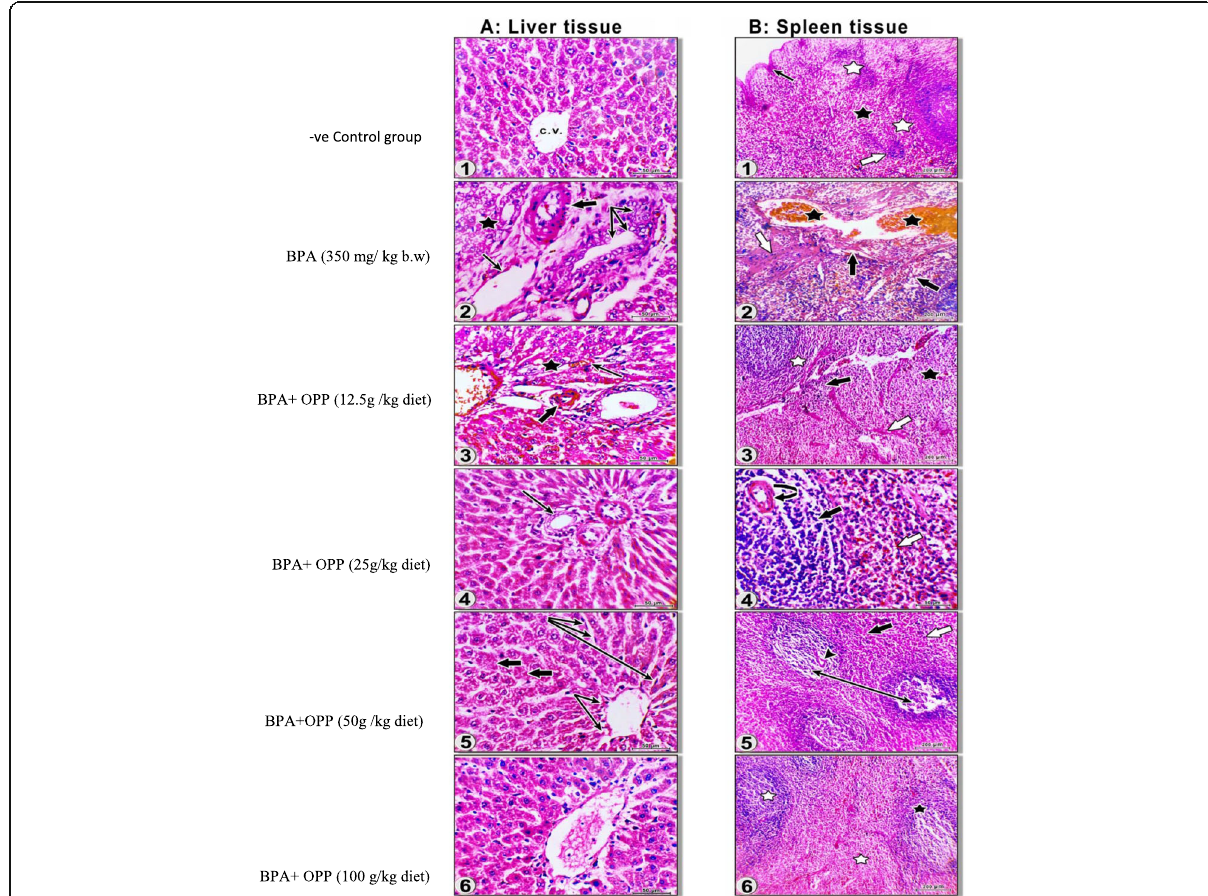
Fig. 1 a Photomicrographs of hepatic micro-anatomical structures. (1) Control group illustrating normal hepatocytes and central vein (cv), (H&E × 400). (2) Rats administered BPA (350 mg/kg b.w/twice weekly) showing necrotic area (star), bile duct hyperplasia (3 arrows), hypertrophy portal artery (thick arrow) dilated vein (thin arrow), and (H&E × 400). (3) Rats administered BPA and orange peel powder (12.5 g/kg diet), illustrating the hemorrhage (thin arrow), fibroid with lymphocytes infiltration (thick arrow), and areas markedly improved (star), (H&E × 400). (4) Rats administered BPA and OPP (25 g/kg diet) showing slightly improvement in periportal area, well-developed duct (arrow), and the little apoptotic body (H&E × 400) (5). Rats administered BPA and OPP (50 g /kg diet) illustrating partially improvement, Kupffer cell (3 arrows), restoring hepatocytes with necrotic cells (thick arrows), and central vein wall rupture (2 arrows) (H&E × 400). (6). Rats administered BPA and OPP (100 g/kg diet) pointed out to clarity of hepatocytes regeneration (H&E × 400). b Photomicrographs of splenic micro anatomical structures. (1) Control group capsule of cortex (black arrow) and the white pulp (white stars), red pulp (black star) trabecular, and central artery (white arrow) (H&E × 100). (2) Rats administered BPA (350 mg/kg b.w/twice weekly) showing marginal zones disfaberic (black arrows) fibrotic tissue (white arrow) and dilated vein with hemorrhaged bulge (stars) (H&E × 100) (3). Rats administered BPA and OPP (12.5/kg diet) illustrating PALS atrophy (white star), fibroid bands (white arrow), inflammatory lymphocytes (black arrow), and red pulp reduction (Black star) (H&E × 100) (4). Rats administered BPA and OPP (25 g/ kg diet) showing both splenic cords and sinuses malfunction (white arrow), dissociation white pulp (black arrow), and atrophied artery (curved arrow) (H&E × 400) (5). Rats administered BPA and OPP (50 g kg diet) revealing necrotic white pulp (long arrow), atrophied artery (arrow head), and markedly improvement splenic tissue (white + black arrows) (H&E × 100). (6) Rats administered BPA and OPP (100 g/kg diet) pointing out to improvement in pulps, splenic medullary tissue (white stars), and white core rearranged (black star) (H&E ×